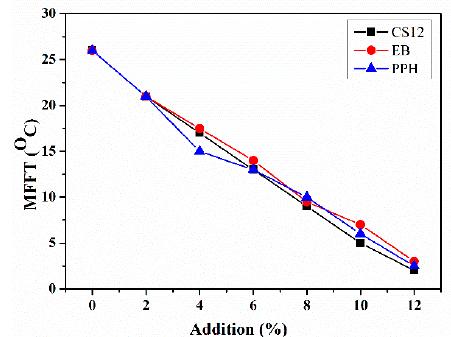
Figure 7. The effect of film-forming additives on the waterborne fluoropolymer. CS12: 2,2,4- trimethylpentanediol monobutyrate; EB: ethylene glycol monobutyl ether; MFFT: minimum film-forming temperature; PPH: propylene glycol phenyl ether.